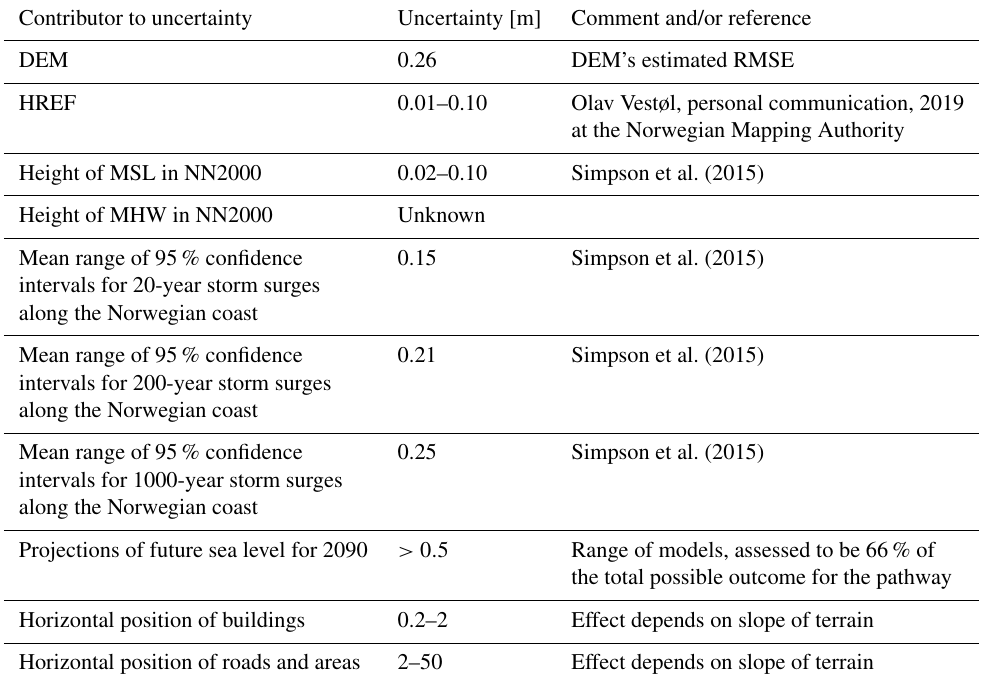
Table 7. Quantitative assessment of effects contributing to the accuracy of the mapping.